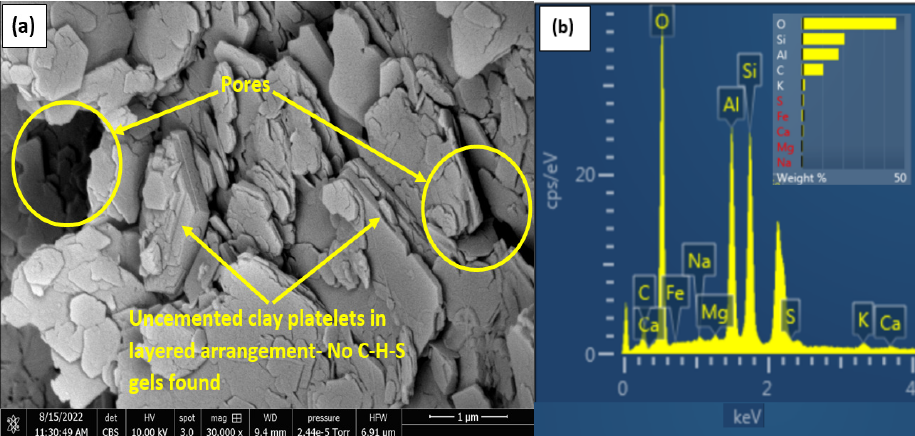
Figure 11. SEM and EDS result of untreated 0%Gypseous soil (Pure Kaolin). ( a ) SEM and ( b ) EDX.